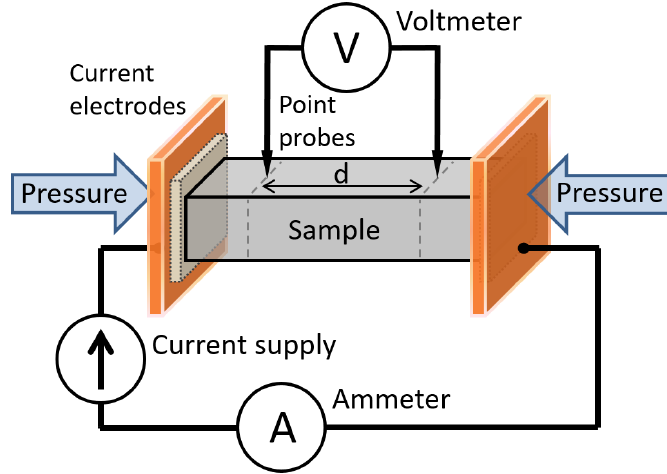
Figure 4. Scheme of the four-probe setup used for bulk